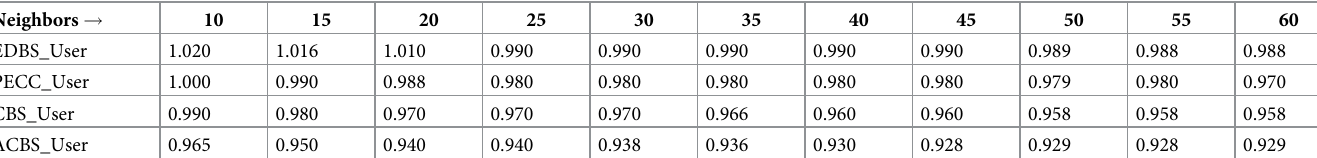
Table 5. RMSE values of different similarity methods as value of neighbors increases.